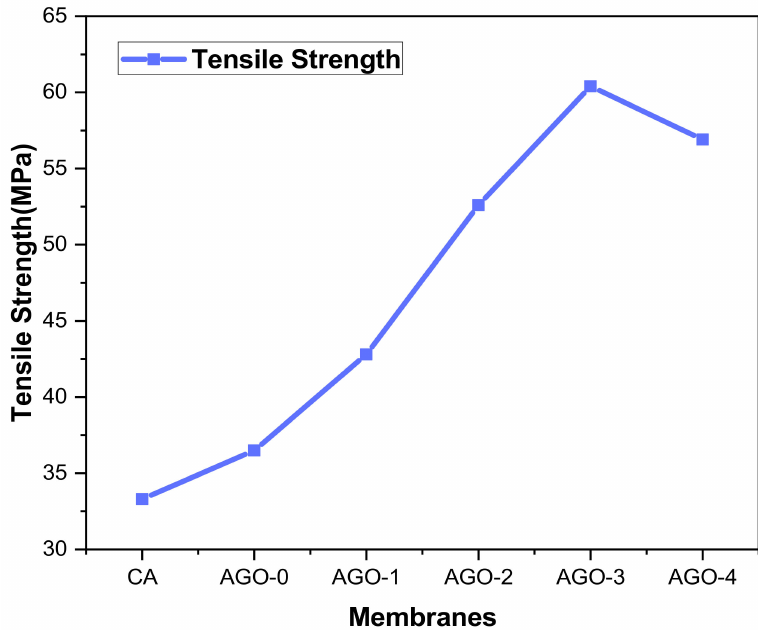
Figure 11. Tensile strength of AGO